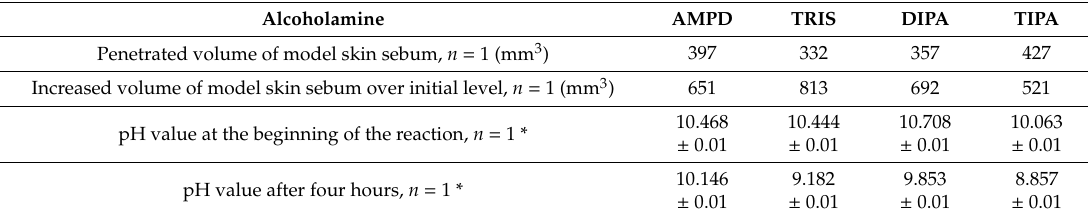
Table 1. Alcoholamine comparison. Values of penetrated volume, increased volume, and pH after four hours of observation.